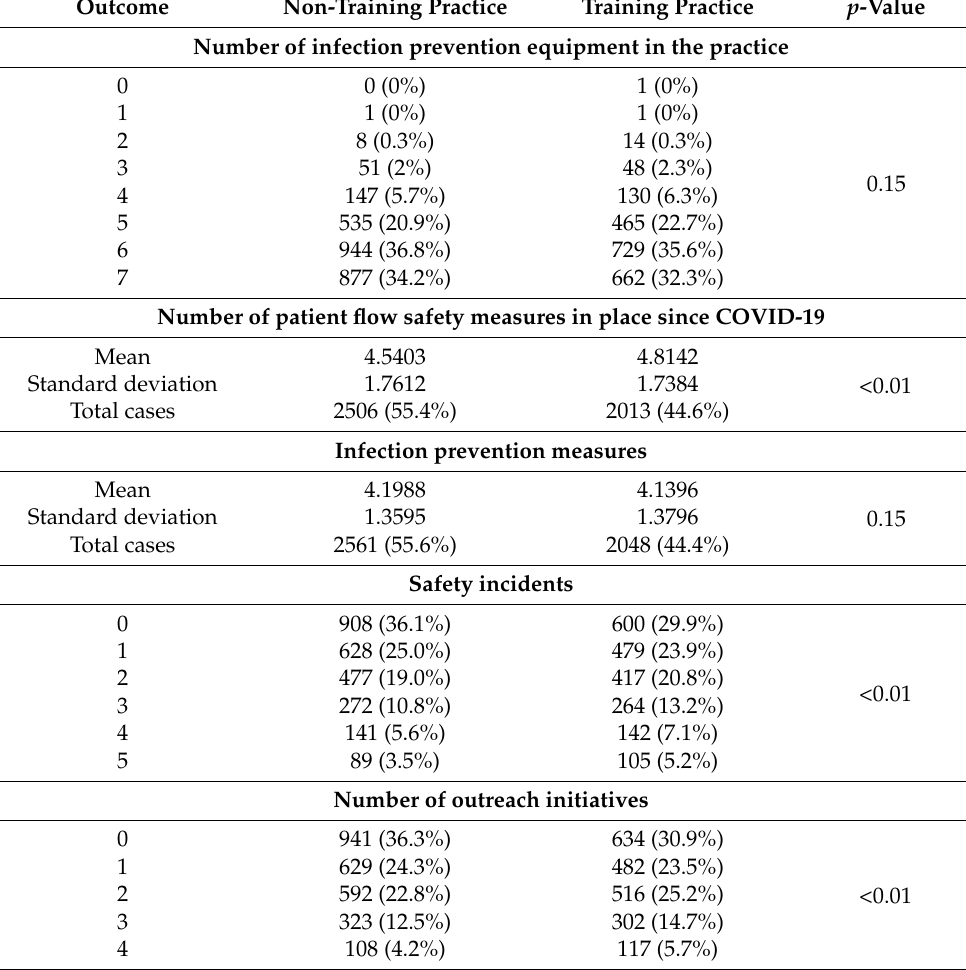
Table 2. Distribution of outcome variables among training and non-training practices and bivariate analysis. Outcome Non-Training Practice Training Practice p -Value Number of infection prevention equipment in the